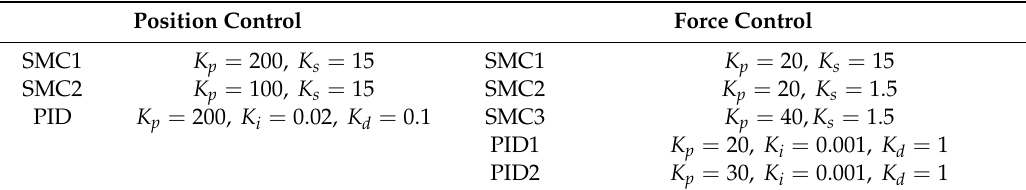
Table 4. The parameters of the control for each experiment.